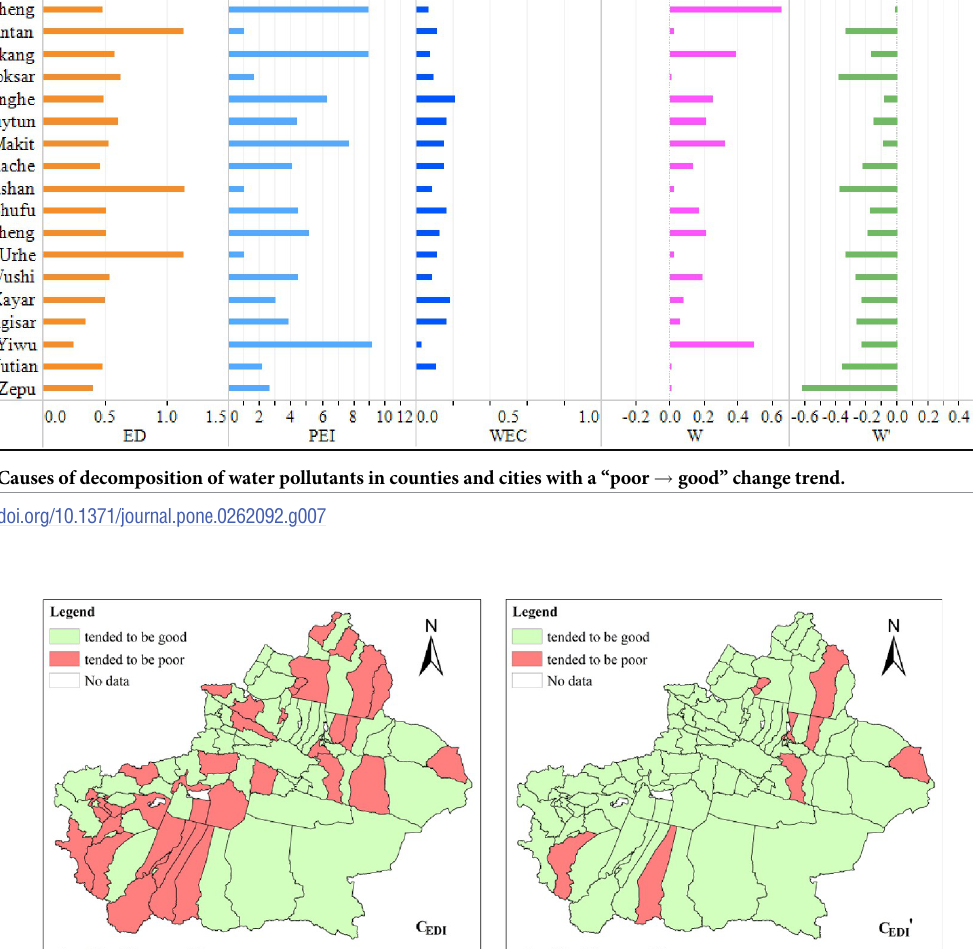
PLOS ONE | https://doi.org/10.1371/journal.pone.0262092 January 21,